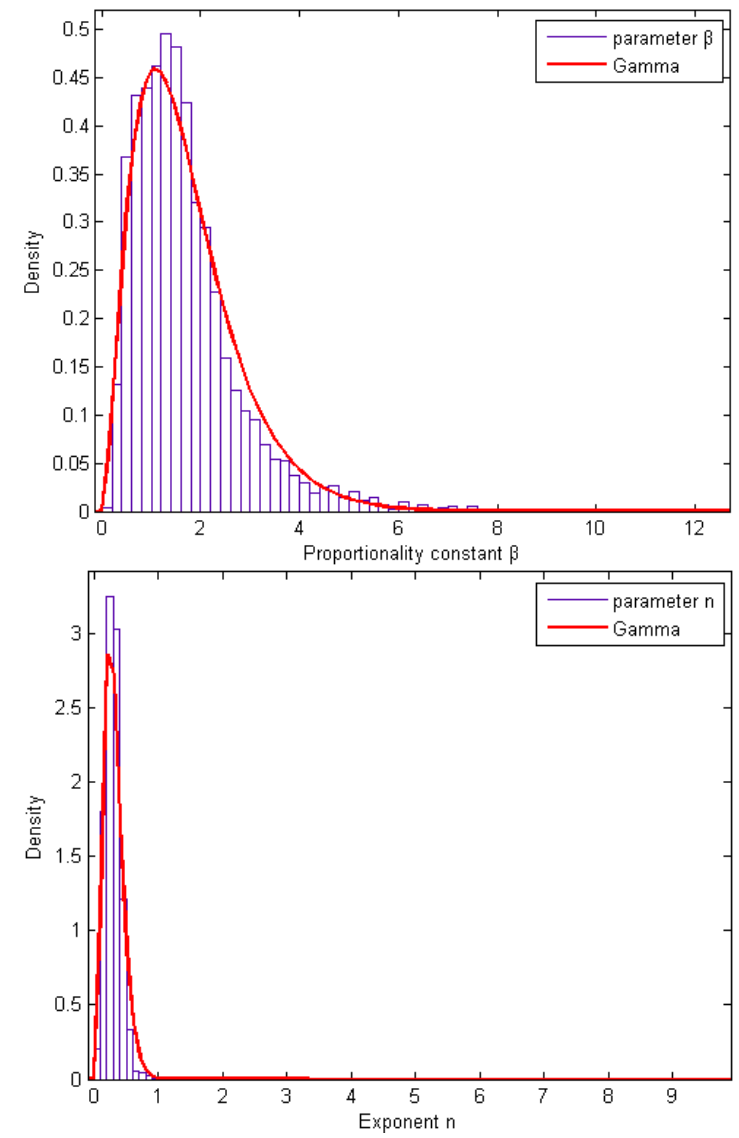
Figure 1. The probability density functions of parameters β and n and the fit of the Gamma